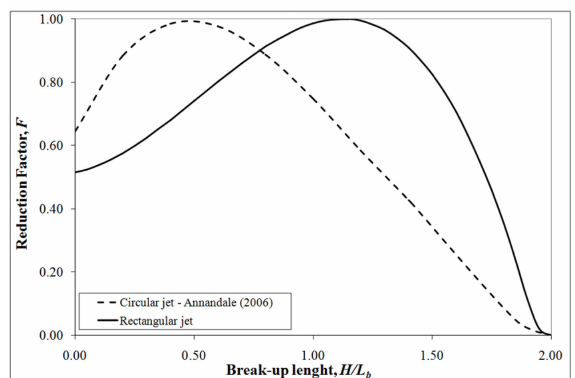
Figure 6. Reduction factor F of fluctuating dynamic pressure coefficient in function of ratio H / L b and the jet type (Castillo et al. [27]).